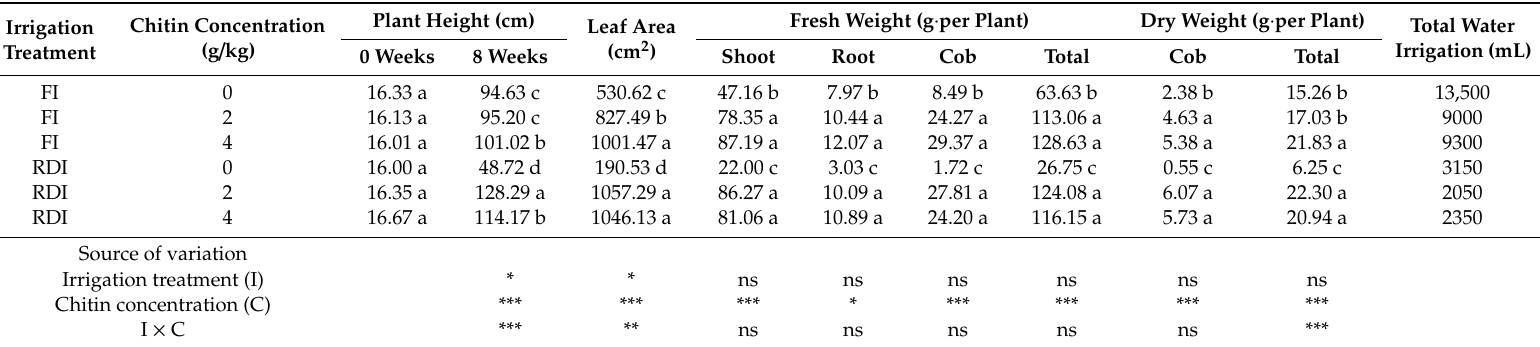
Table 3. E ff ects of di ff erent concentrations of chitin on the agronomic performance of maize under full irrigation (FI) and regulated deficit irrigation (RDI). Irrigation Treatment